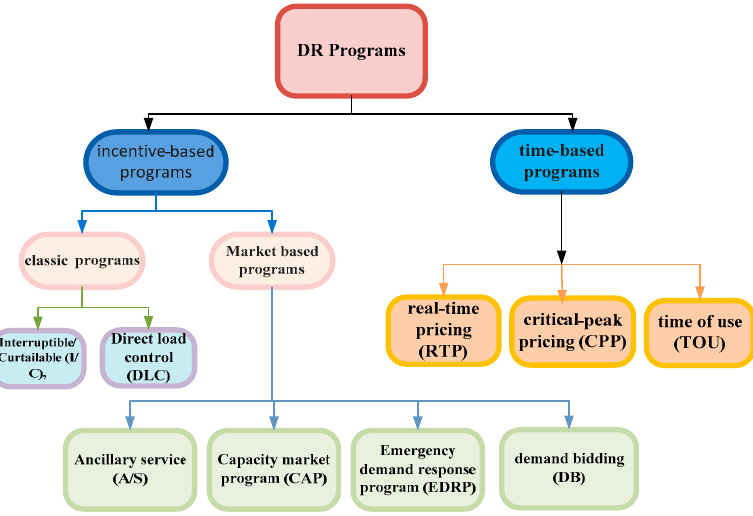
Figure 11. Demand response classifications [98].